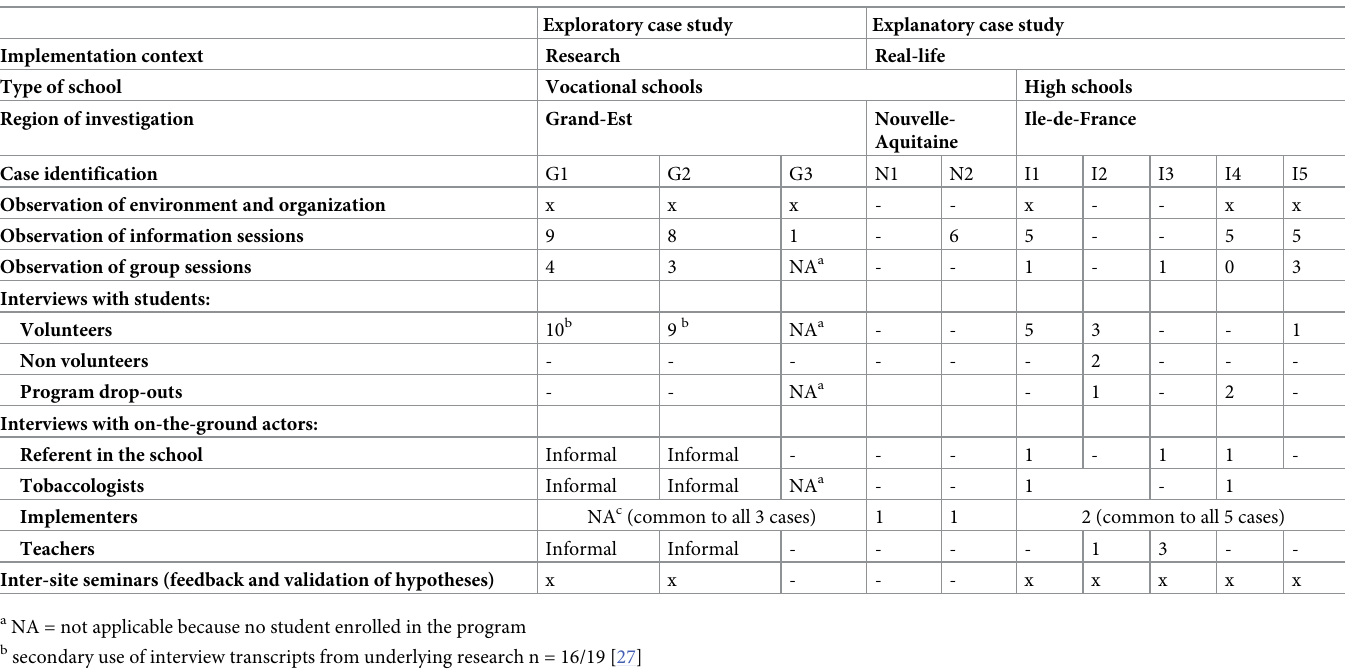
Table 1. Multiple case study: Type of investigation per